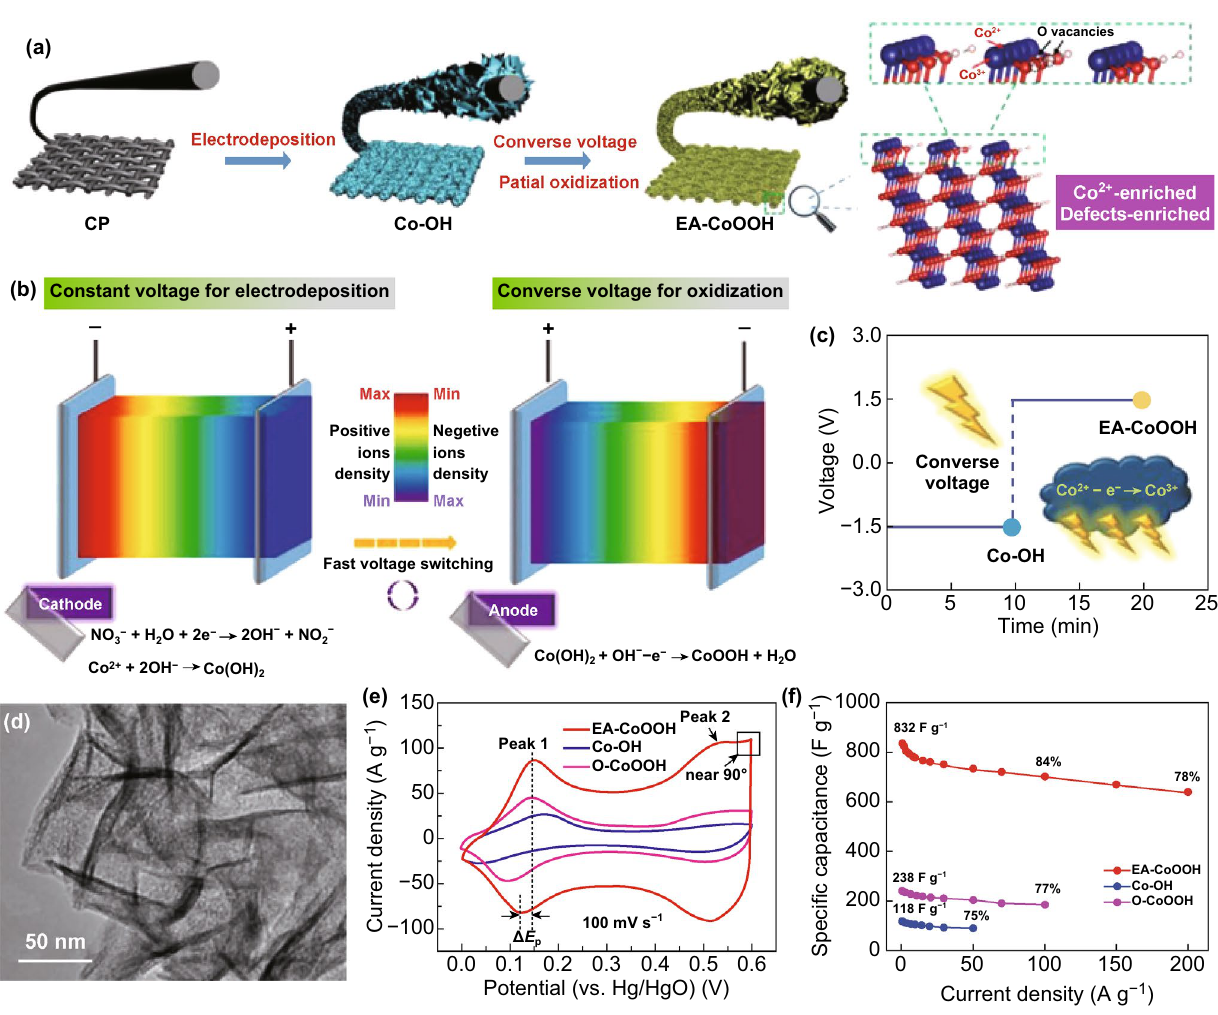
Fig. 27 a Schemes of the synthesis steps of EA‑CoOOH by a converse voltage method and the molecular structure of Co 2+ ‑ and defect‑rich EA‑CoOOH. b Schemes showing the ion concentration gradients during constant voltage for electrodeposition (left) and converse voltage for oxidization (right). c Voltage profiles of electrodeposition and converse voltage stages. d TEM image of EA–CoOOH. e CV curves and g rate capability of EA–CoOOH in comparison with other electrodes. Adapted from Ref. [268] with